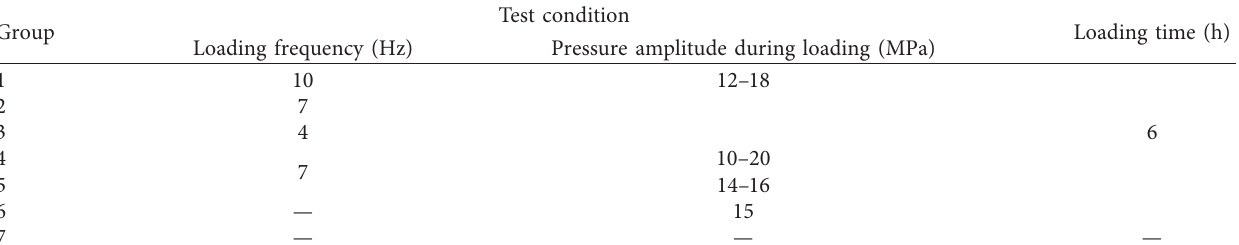
Figure 1: Location of Yangquan mining area. Table 1: Loading conditions for the cyclic loading tests.